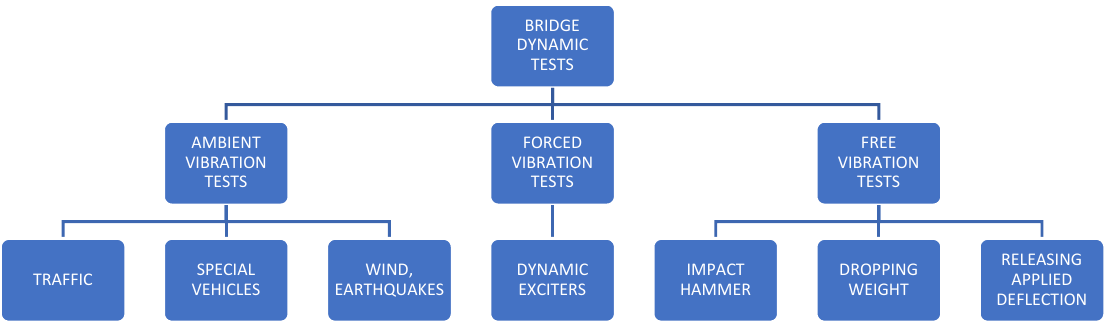
Figure 1. Schematic view of the main dynamic tests on bridges.